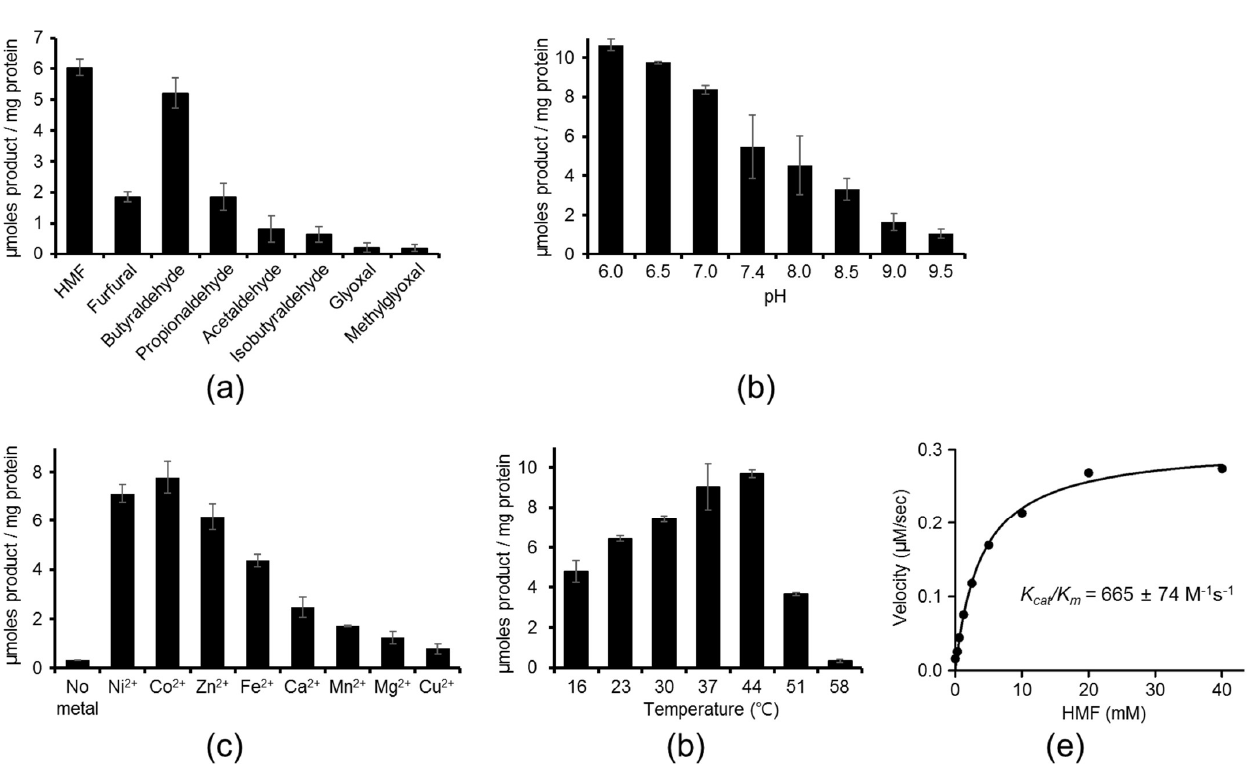
Figure 1. Catalytic properties of YugJ. ( a ) Substrate specificity of YugJ as an aldehyde reductase. The catalytic activity of recombinant YugJ protein toward diverse aldehydes was determined in the presence of NADPH and Ni 2+ at pH 7.4 by monitoring NADPH oxidation, which was measured by a decrease in 340 nm absorbance. ( b ) pH dependence of YugJ-mediated catalysis. The HMF reduction activity of YugJ was determined at different pH values in the presence of NADPH and Ni 2+ . ( c ) Metal dependence of YugJ-mediated catalysis. The HMF reduction activity of YugJ was determined in the absence or presence of a divalent metal ion at pH 7.4 with NADPH. ( d ) Temperature dependence of YugJ-mediated catalysis. The HMF reduction activity was determined at different temperatures at pH 7.4 in the presence of NADPH and Ni 2+ . ( e ) Catalytic efficiency of the HMF reductase YugJ derived from the Michaelis–Menten curve. The enzymatic activity of YugJ was determined at different HMF concentrations in the presence of NADPH and Ni 2+ at pH 7.4.